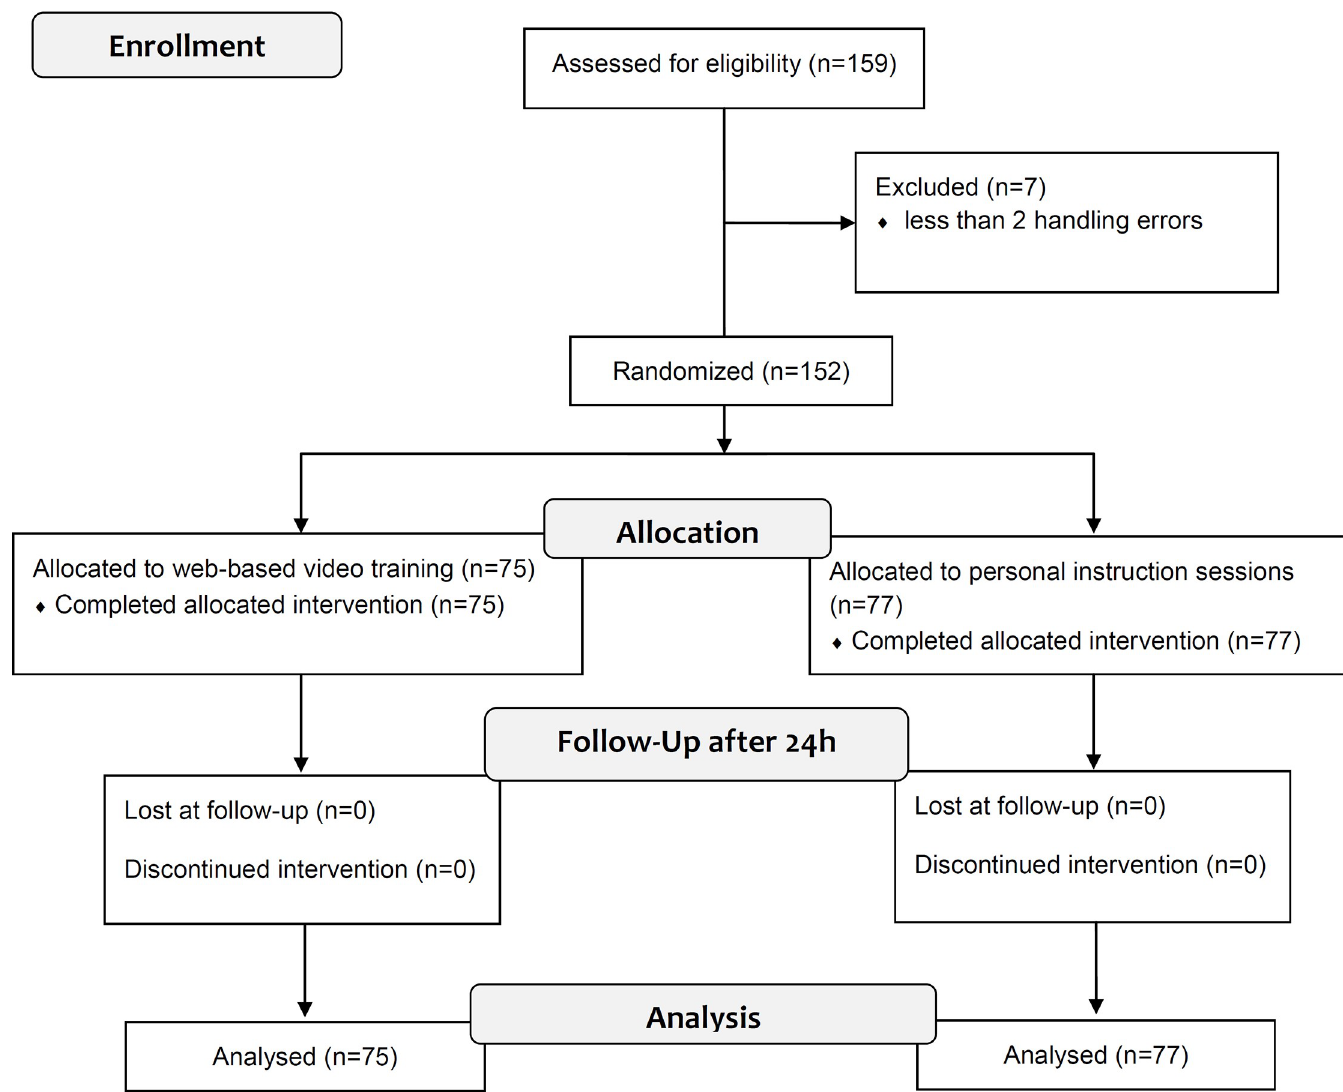
Fig 1. Flowchart of the study design according to the CONSORT 2010 Statement